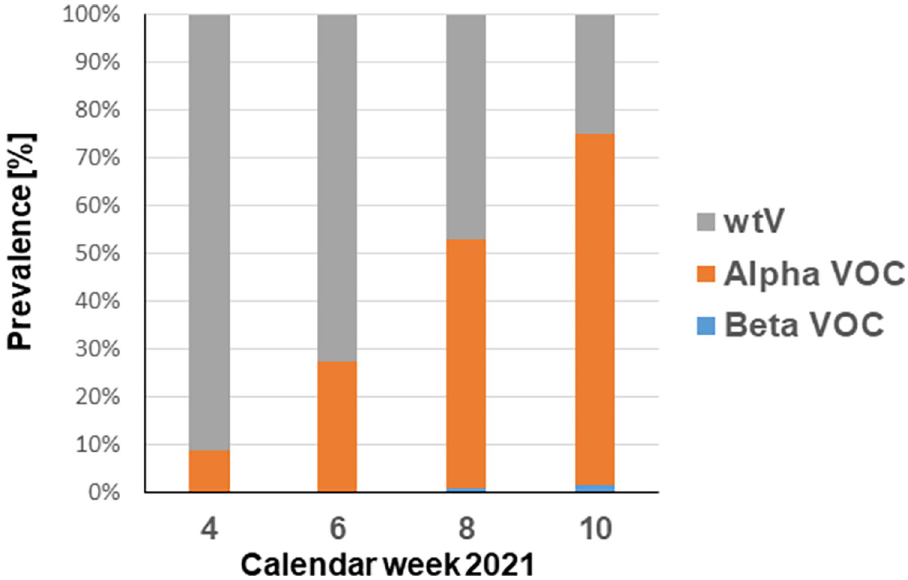
Fig 1. Prevalence of all positives of wild type SARS-CoV-2 (wtV) and the Alpha and Beta VOCs. https://doi.org/10.1371/journal.pone.0271808.g001 Due to the low case number (n = 15), the Beta VOC was excluded from further analysis. Table 1 shows the results of the remaining samples (n = 1858) using a Mann-Whitney-U two- group comparison as described in other publications [e.g. references 5 and 6]. Significantly, lower Ct values of the Alpha VOC were detected for the factor gender (p < 0.0001), outpatients (p < 0.0001), and age groups 0–80 years (p < 0.004). The rate of inpatients carrying the Alpha VOC (28/845) was significantly lower than those carrying wtV (59/1013, p = 0.011). The time between the onset of symptoms and the day of sampling could be determined cross-sectionally